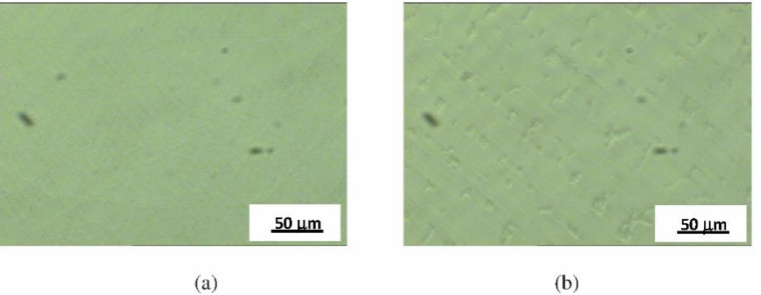
Figure 5. Microstructures after electrochemical treatments for ( a ) specimen Co2 and ( b ) specimen Co1.